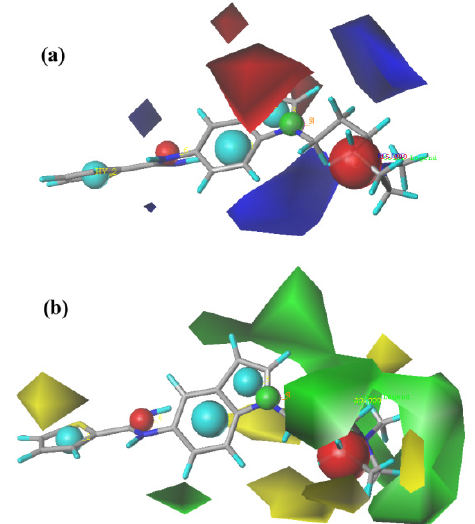
Figure 4. ( a ) CoMFA steric contour maps and ( b ) CoMFA electrostatic contour